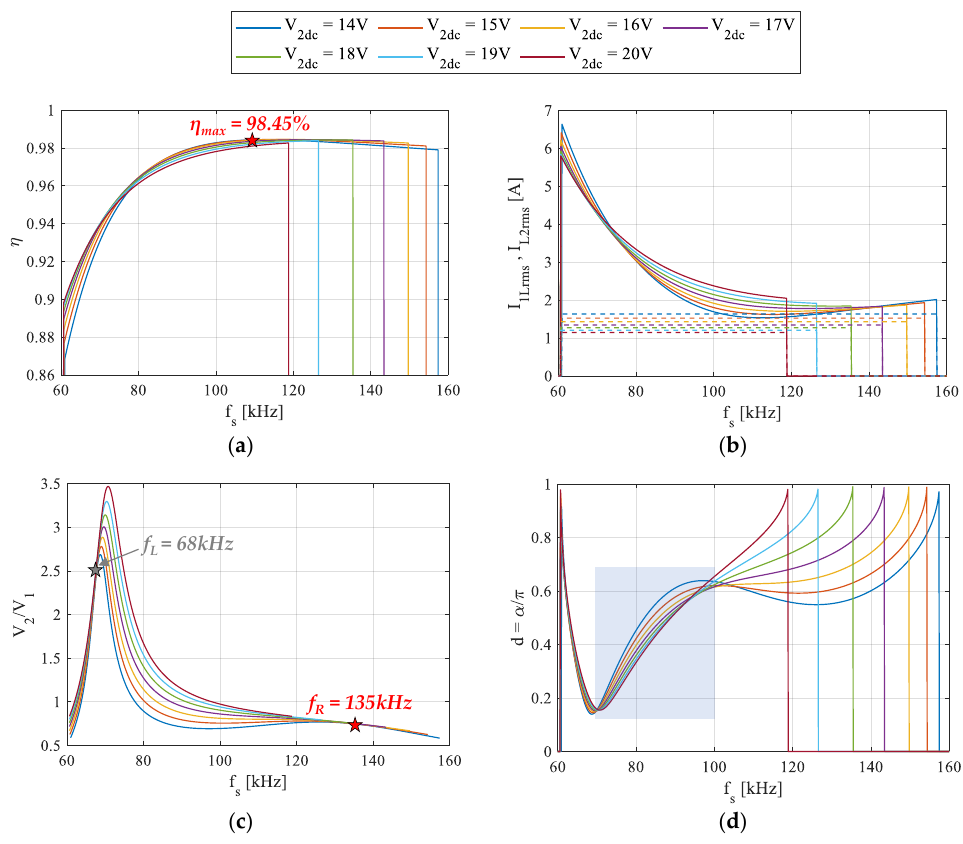
Figure 13. Predictions of IPTS modeling solution (5) – (8) vs. f s for different values of V 2 dc , for the capacitor set-up { C 1 = 200 nF, C 2 = 100 nF}: ( a ) IPTS efficiency η ; ( b ) TX and RX coil rms currents I L 1rms (solid), I L 2rms (dashed); ( c ) IPTS RX-to-TX voltage gain V 2 / V 1 ; and ( d ) normalized phase-shift d .